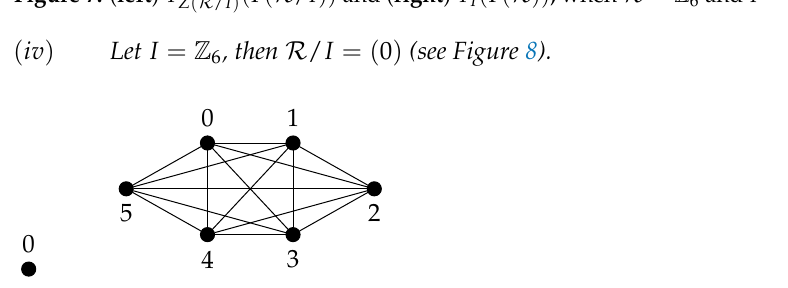
Figure 8. ( left ) T Z ( R / I ) ( Γ ( R / I )) and ( right ) T I ( Γ ( R )) , when R = Z 6 and I = Z 6